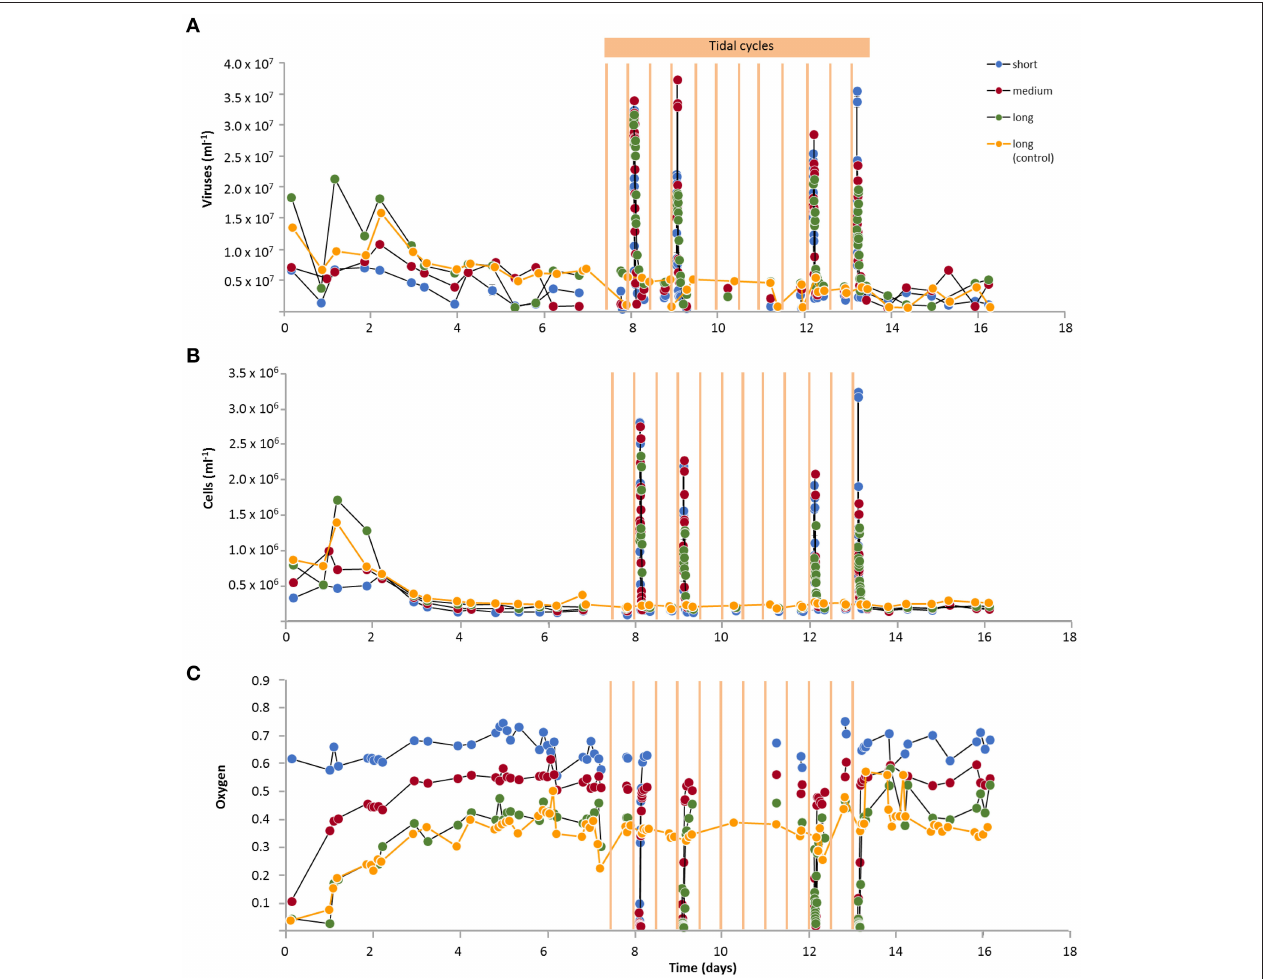
FIGURE 2 | Virus and cell numbers and oxygen concentrations in effluents of sediment columns of different lengths (short, medium, 2 × long) with Janssand sediment (February) for 16 days of experimental run time. Tidal cycle simulation experiments were started after 7.5 days with three reactors, where the water flow in the reactors was stopped for 6h followed by 6h with continuous water flow. Tidal cycles were run twelve times in total. Only four tidal cycles (day 8, 9, 12, and 13) were sampled directly after restarting of the water flow for analyses of (A) virus numbers, (B) cell numbers, and (C) oxygen concentrations. Oxygen concentrations in the effluents are plotted relative to the oxygen concentrations of the reservoir. Oxygen concentrations during the tidal simulation were only measured in effluents of two reactors each time. The water flow was continuous in one long sediment column